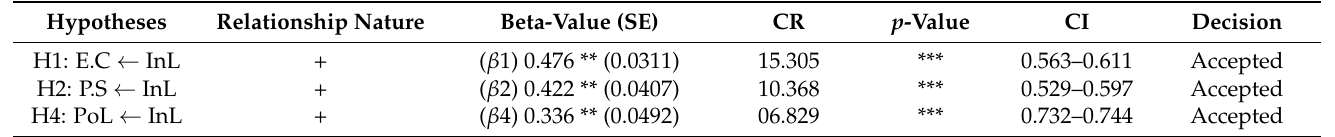
Table 5. Direct effect structural model results.